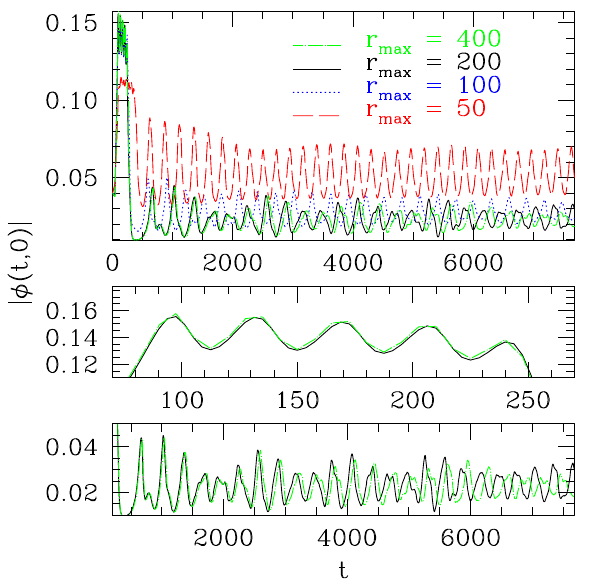
Fig.14 Verylongevolutionsofaperturbed,slightlysub-critical,bosonstarwithdifferingouterboundaries. The central magnitude of the scalar field is shown. At early times ( t < 250 and the middle frame), the boson star demonstrates near-critical behavior with small-amplitude oscillations about an unstable solution. For late times ( t > 250), the solution appears converged for the largest two outer boundaries and suggests that sub-critical boson stars are not dispersing. Instead, they execute large amplitude oscillations about low-density boson stars. Reprinted with permission from Lai and Choptuik